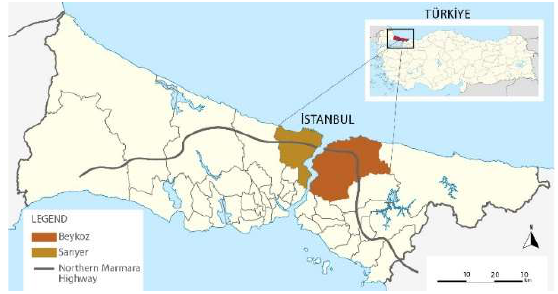
Figure 1. Study area.